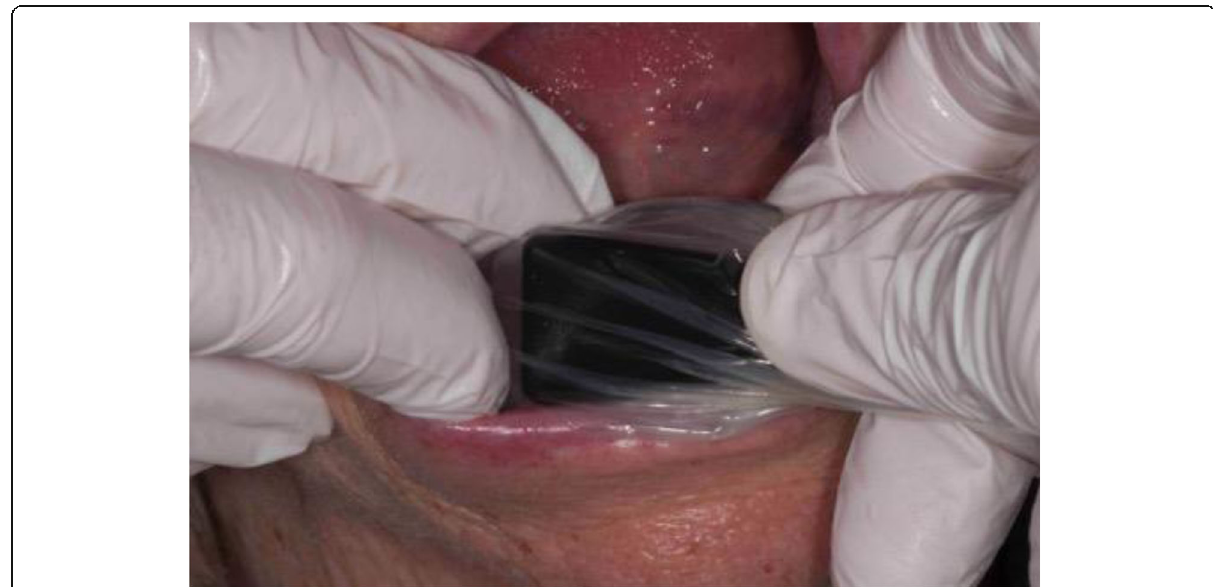
Fig. 5 Intraoral placement of the here reported high-resolution ultrasound probe (up to 60 μ m) with protective cover and gel standoff pad